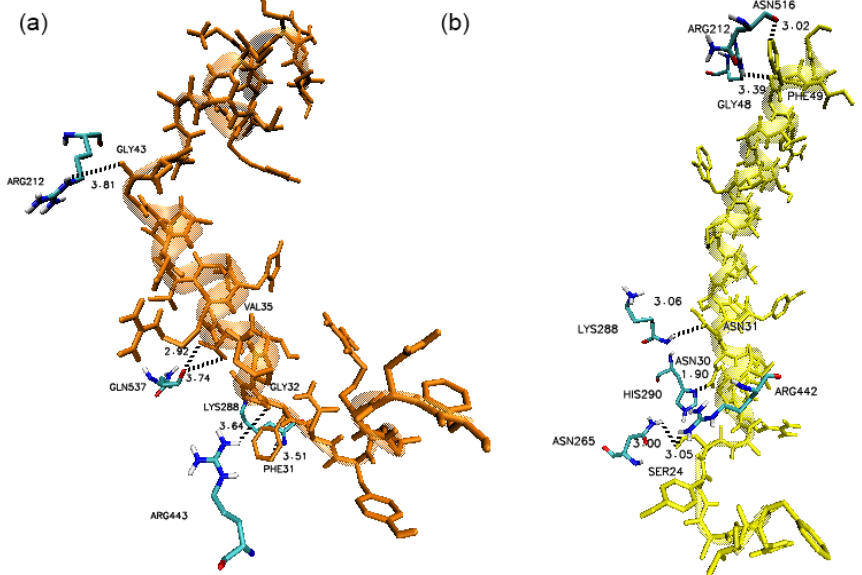
Figure 8. Binding conformation of ( a ) PlnE and ( b ) PlnF. Hydrogen bonding cut-off is set at 4.0 Å.